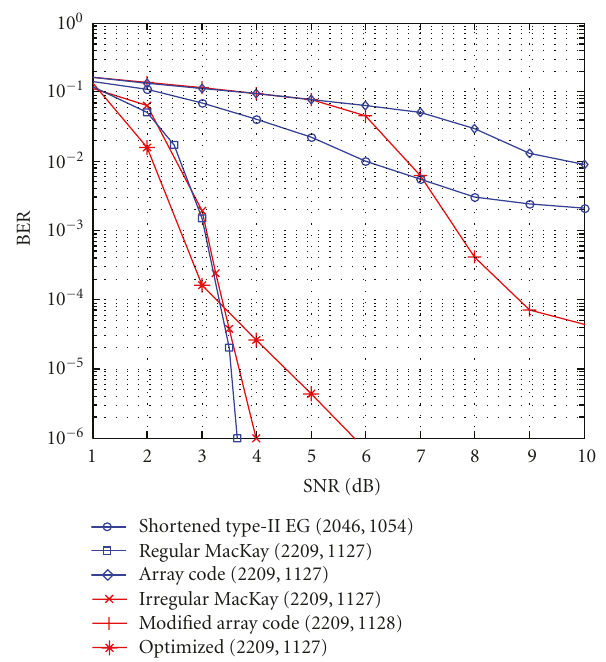
Figure 3: BER versus SNR for a single carrier system with LDPC codes (code rate ≈ 0 . 51) over an AWCN channel ( A = 0 . 1, GIR = 0 . 001).